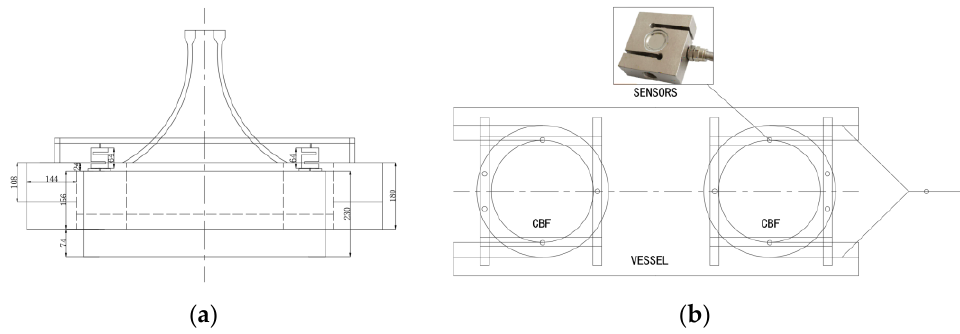
Figure 5. Sensor arrangement: ( a ) sensor installation on CBF; ( b ) sensor position on CBF.